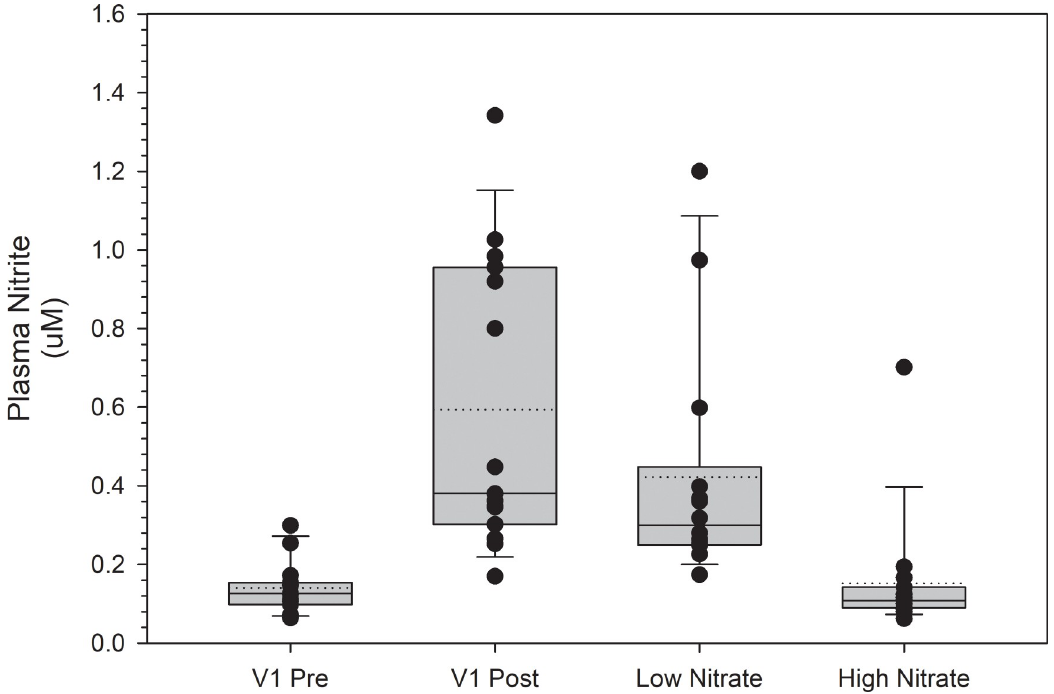
Fig 4. Plasma NO2- levels at visit 1 (V1) and the high and low NO3- beverage trials. Post NO 2- levels at V1 were obtained two hours post consumption of a high NO 3- beverage. Plasma NO 2- levels at the high and low NO 3- beverage trials were obtained two hours post consumption of the respective beverage. Plasma NO 2- levels were not significantly different when comparing the high NO 3- beverage trial values to the post consumption values at V1 (p = 1.0) or when comparing the low NO 3- beverage trial values to the pre-consumption values at V1 (p = 1.0). Values are represented as median values with box ends representing the 25 th and 75 th percentiles and error bars representing the 5 th and 95 th percentiles. Dotted lines represent the mean values, and individual dots represent subject